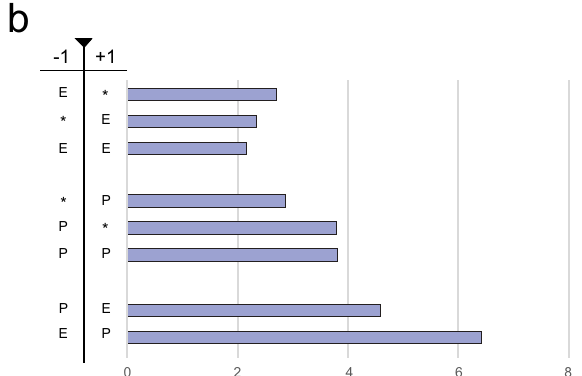
combinatorialenrichmentofaminoacidsinthe − 1and+1positionaroundthenon- Glycine amidated peptides forPPVpredictions above 0.01. The length of the baris the enrichment of the motif compared to the background. Source data are pro- vided as a Source Data fi